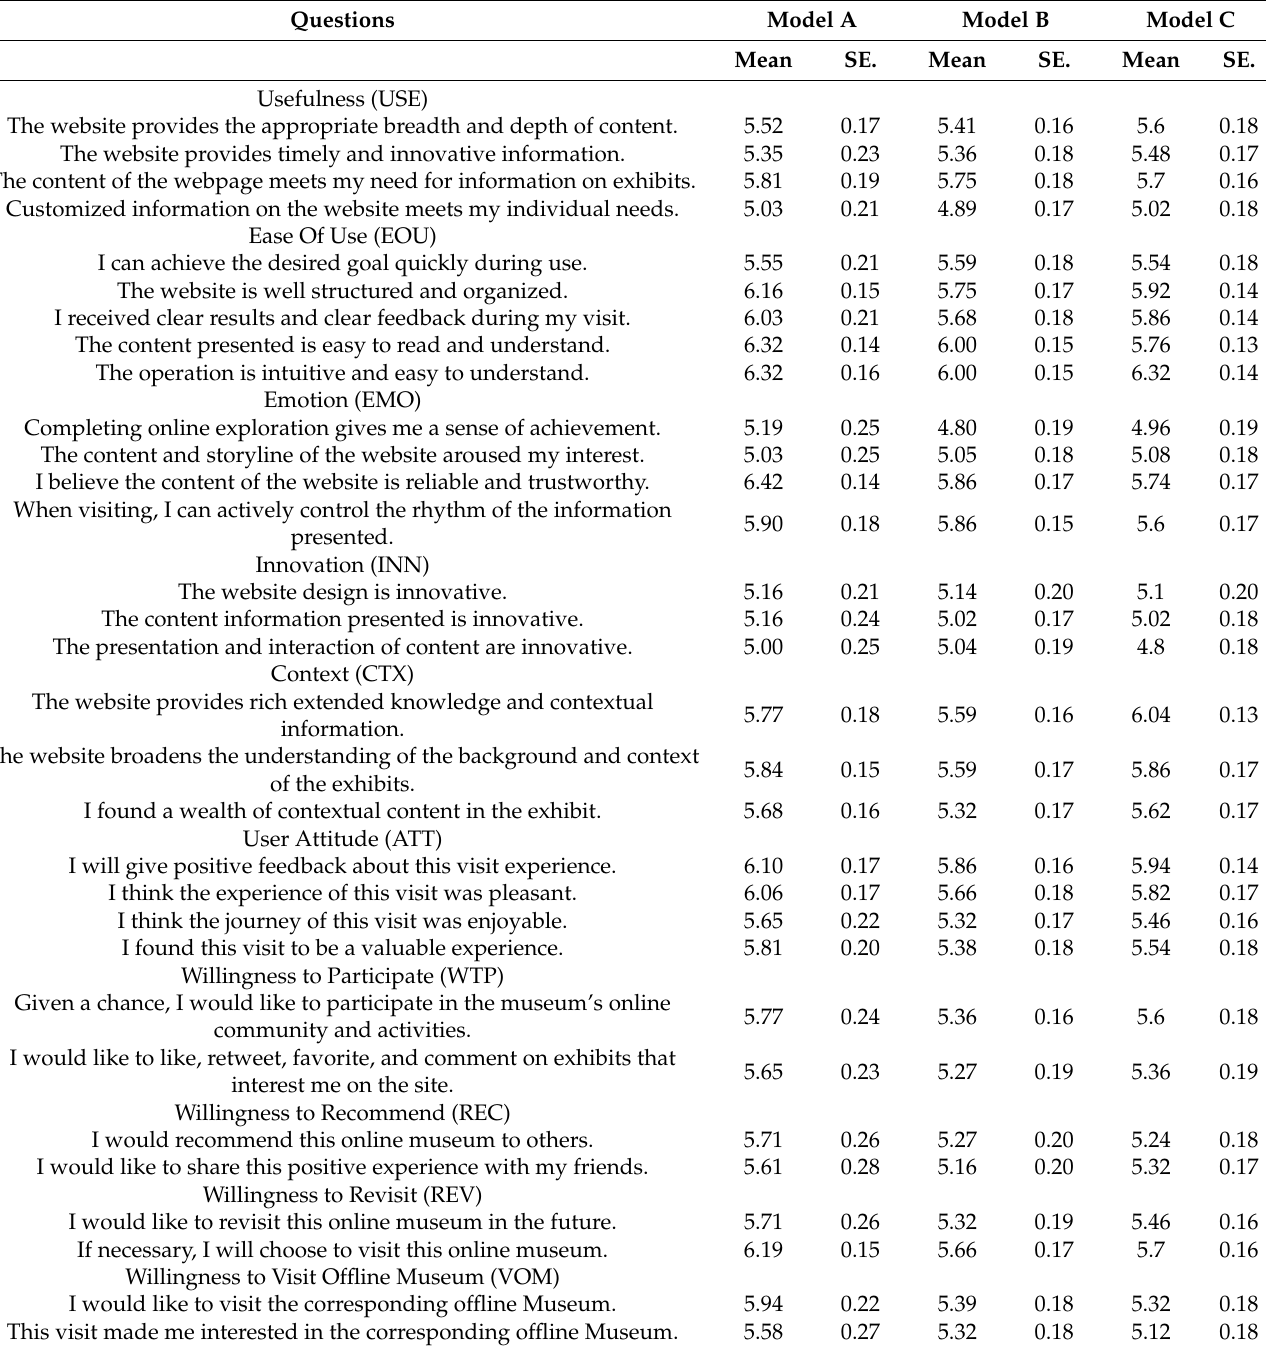
Table 4. Means and standard deviations of all questions of the